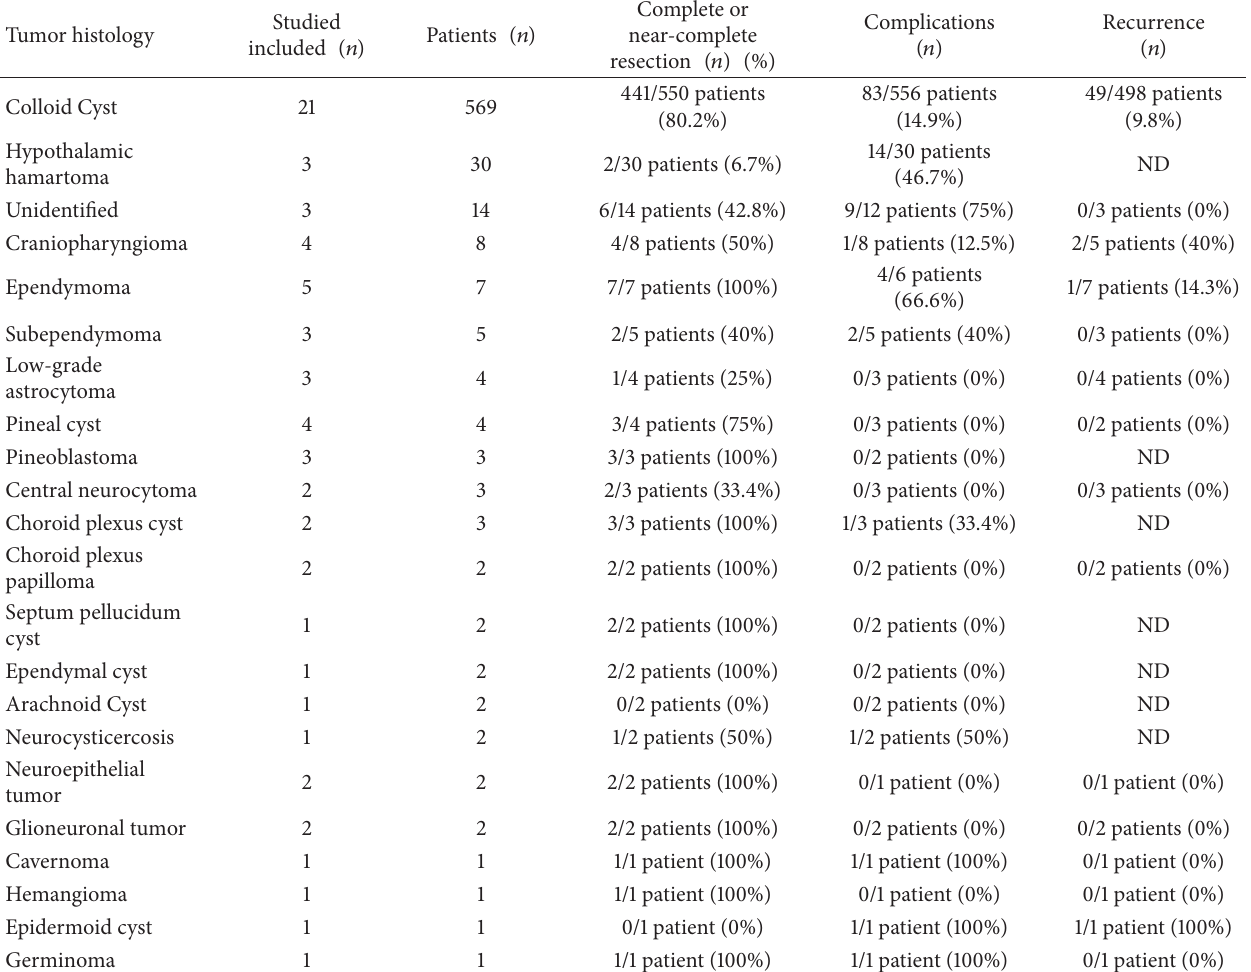
Table 2: displaying the various tumor histologies included in the study with corresponding data regarding the number of studies included, the number of patients, resection success, complication rates, and recurrence rates for each tumor